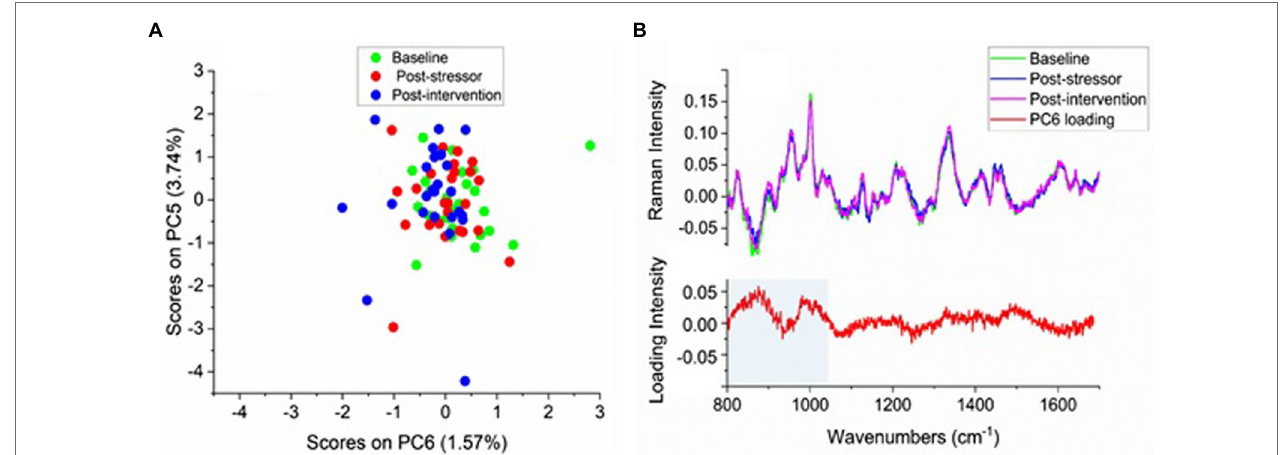
FIGURE 3 | (A) Principal component analysis (PCA) scores colour coded according to time session and (B) Top: the averaged difference spectra (averaged psoriasis—averaged control) for each time-point (light green: baseline, blue: post-stressor, pink: post-intervention), (B) Bottom: loading plot for PC6, with shaded region corresponding to positive loadings for this